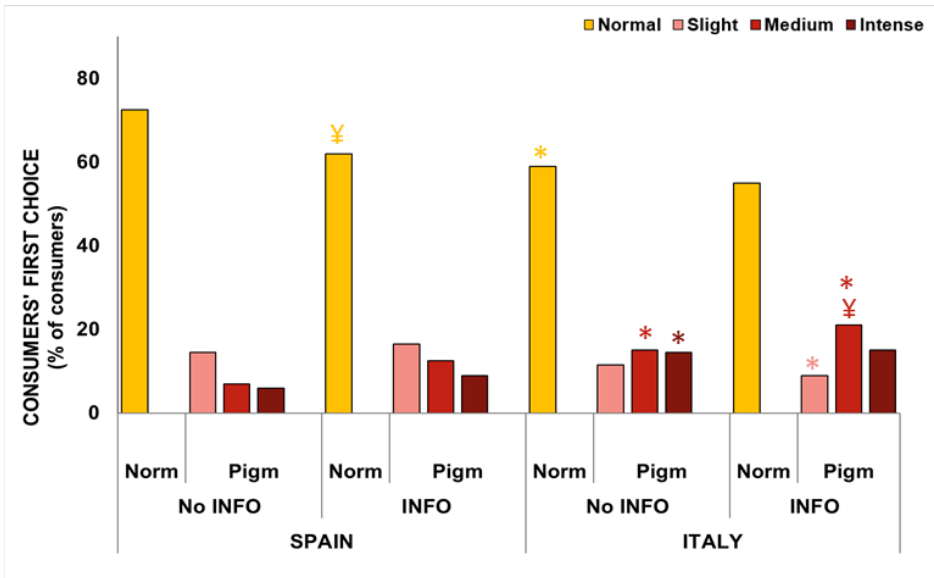
Figure 2. Percentage of consumers from Spain and Italy who indicated each mandarin type (normal-, slight-, medium- and intense-pigmented varieties) as their first choice. The Informed consumers (Info) received information about the antioxidant properties of the pigmented mandarins. ¥ indicates significant differences between the percentage of informed and uninformed participants in each of the countries who selected a specific type of mandarin. * indicates significant differences between the percentage of Italians and Spaniards who selected a specific type of mandarin under the same condition of information.